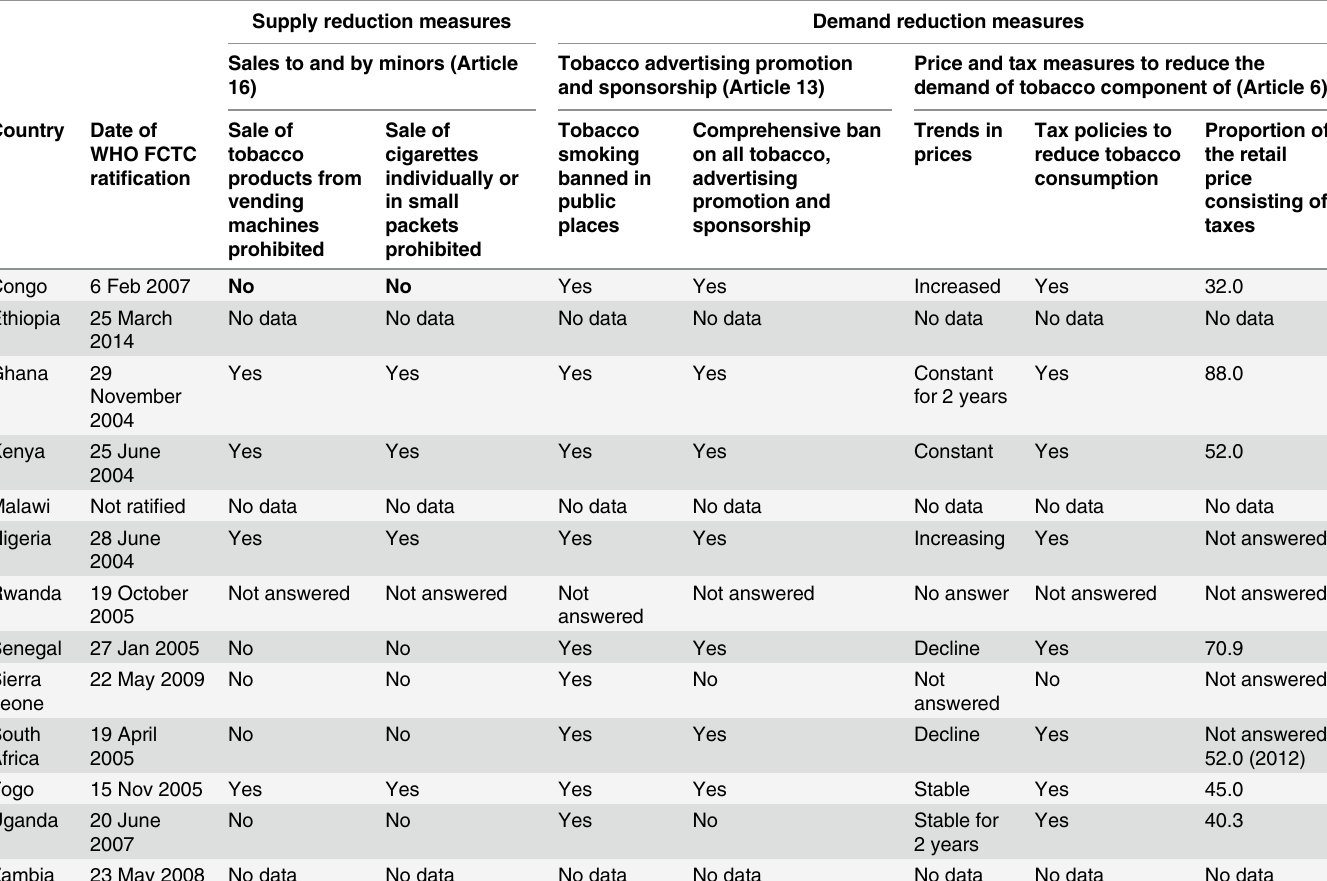
Table 3. Status of the implementation of selected articles under the supply and demand reduction measures, Treaty Provisions of the WHO